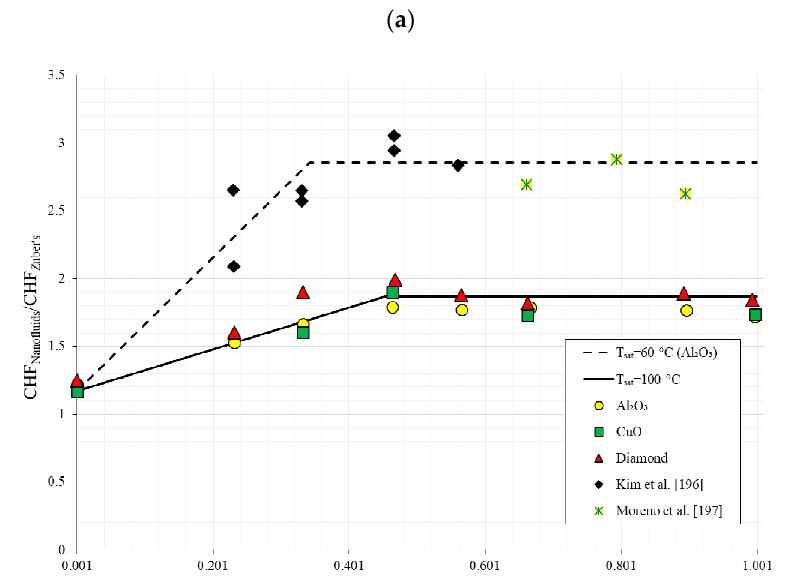
Figure 11. Variations of CHF against volume concentration for diverse nanofluids. Adapted from Prakash and Prasanth. Reproduced from [201], Elsevier: 2018.